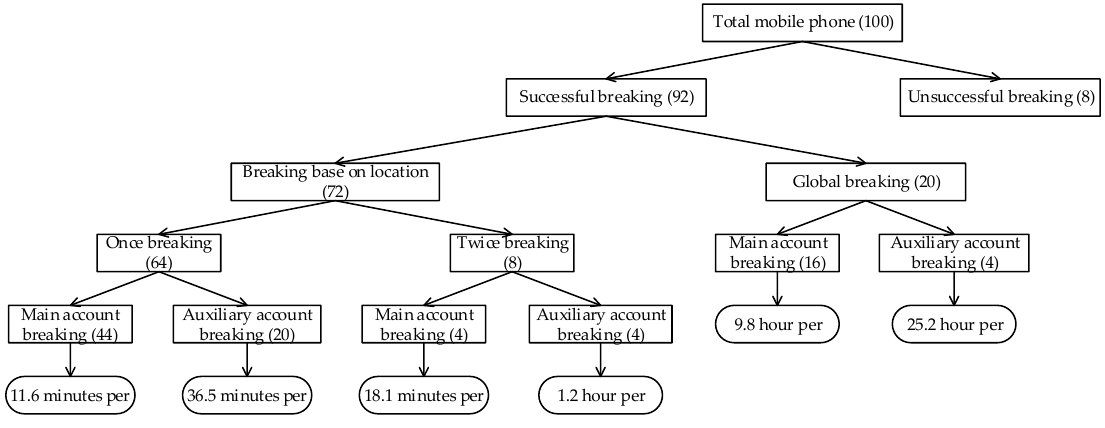
Figure 22. The effect of mobile phone number breaking.